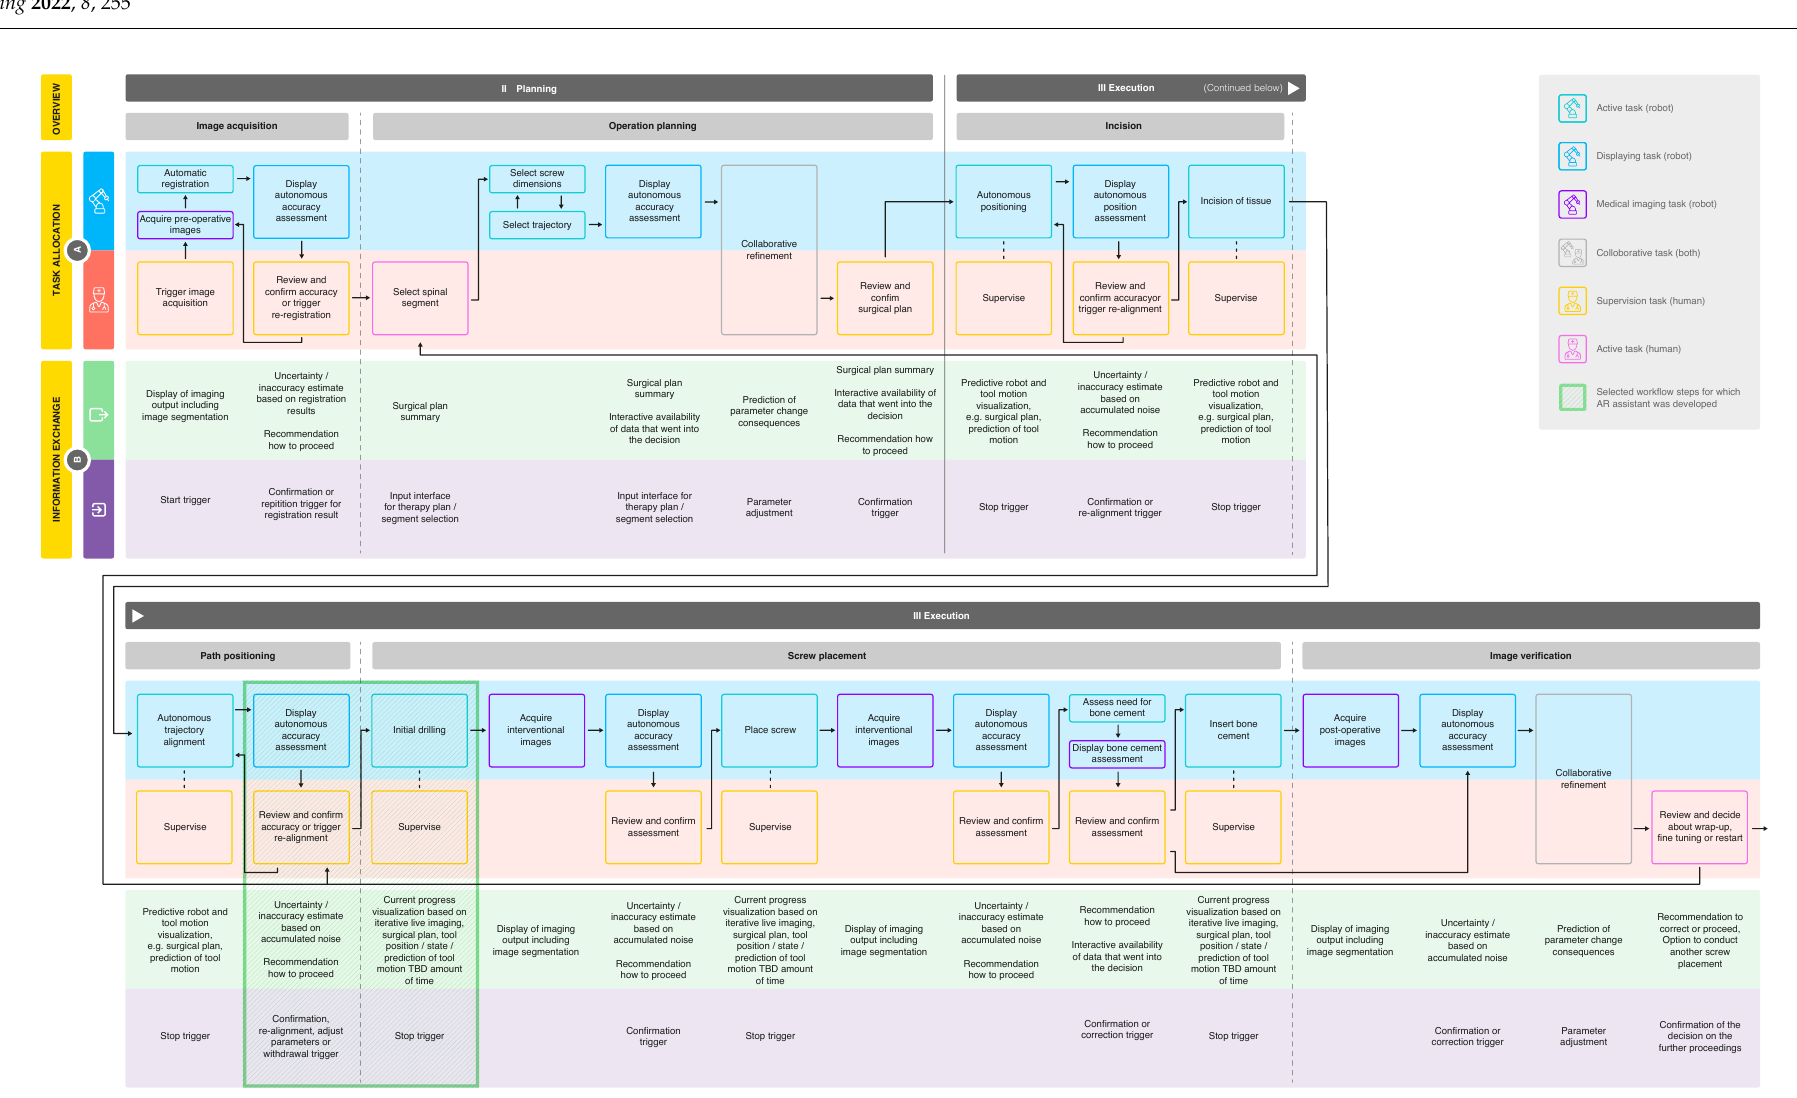
Figure 4. In depth workflow analysis of a futuristic PSP procedure, including task allocation ( A ) and information exchange ( B ) between surgeon and robotic system. Allocated tasks were categorized, and two workflow steps were selected for AR-assistant development (see